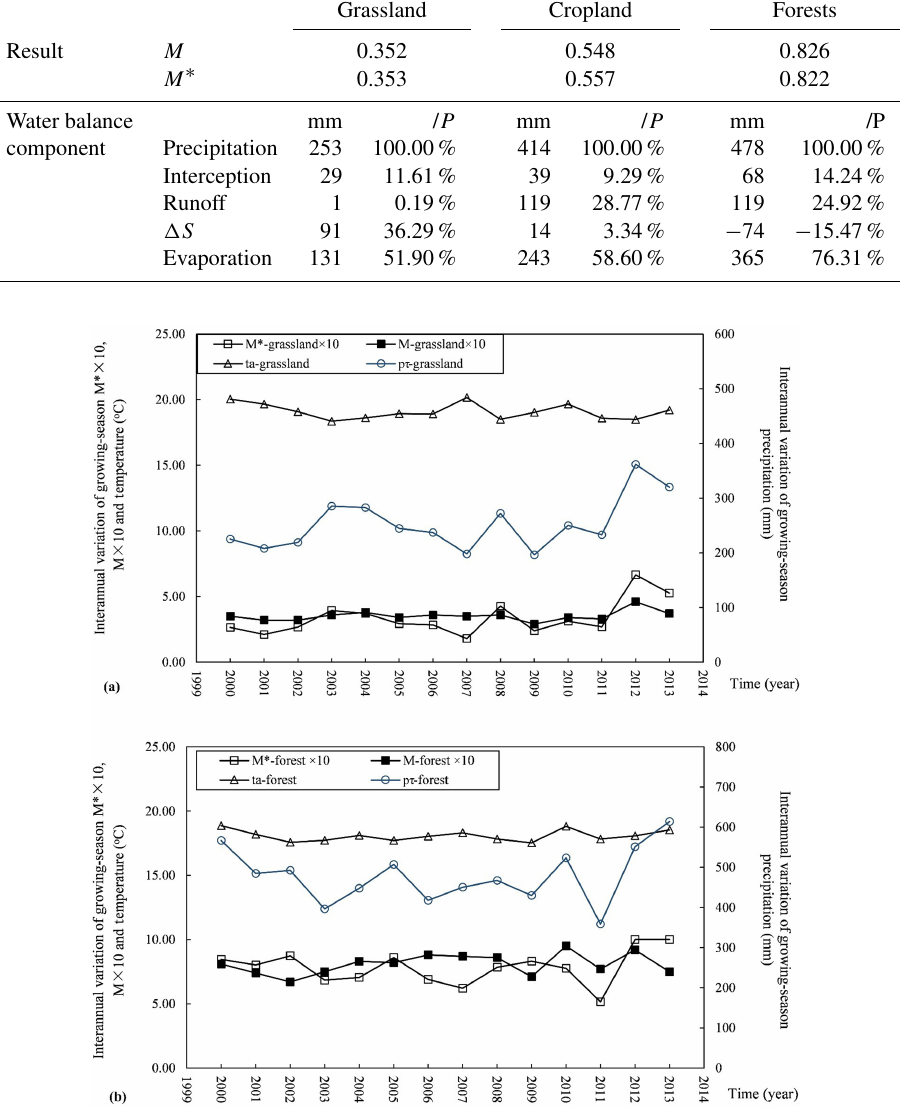
tions of the water balance components for the annual av- erage growing season are calculated for each part based on Eq. (6), as shown in Table 2. According to the research con- ducted before, in the grassland area, the interception was 20.86 and 7.88 % for shrub and grass, respectively (Peng et al., 2014), and the runoff of Xilin Gol grassland occu- pied around 0.046–1.8 % (Wang et al., 2008a; Miao et al., 2008). In the forest area, the dominant tree species are Pinus koraiensis (Pk), Quercus mongolica (Qm), Populus davidi- ana (Pd) and B. platyphylla (Bp) (Chen, 2001; Zhang and Zhou, 2009). The interception consists of 19.61 % for Pk and 14.97 % for Bp in the Greater Khingan Range and 10.20 %